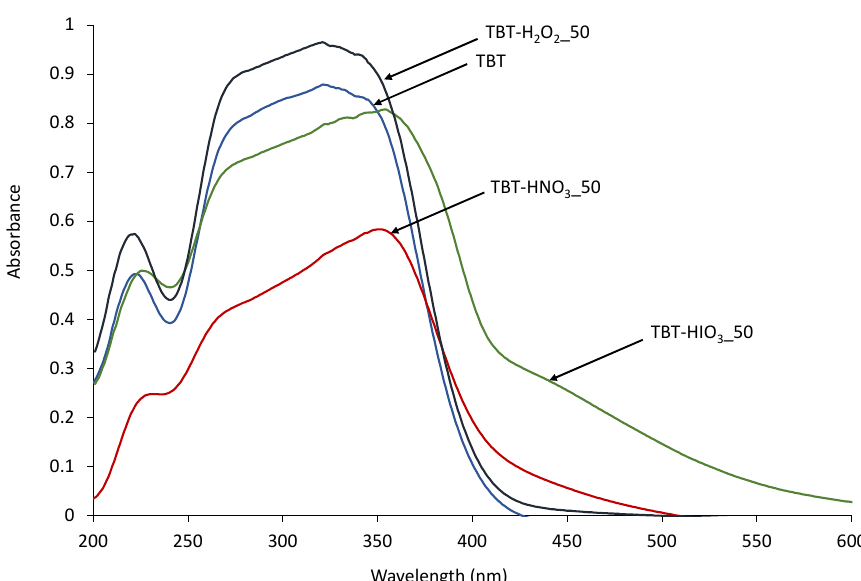
Figure 2. UV-Vis di ff use spectra for pure and defective TiO 2 obtained using di ff erent oxidants. Figure 2. UV-Vis diffuse spectra for pure and defective TiO 2 obtained using different oxidants.